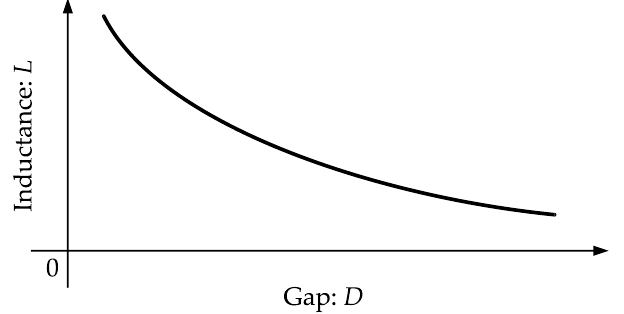
Figure 4. Schematic view of relationship between the inductance and the gap between electromagnet and magnetic target.